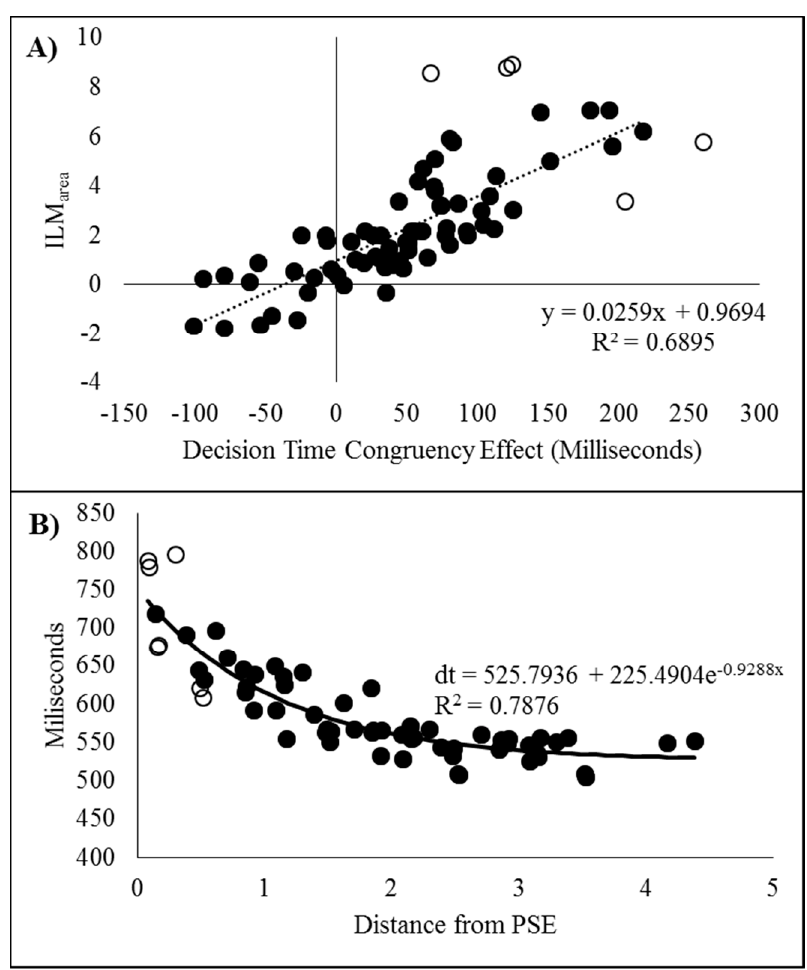
Figure 7. Scatterplots showing the ( A ) correlation between the decision time congruency effect and ILM area and ( B ) the exponential distance decay function relating the decision times to the distance from the point of subjective equality from Experiment 2. The open symbols indicate data pairs that exceeded the Cook’s Distance inclusion criterion.